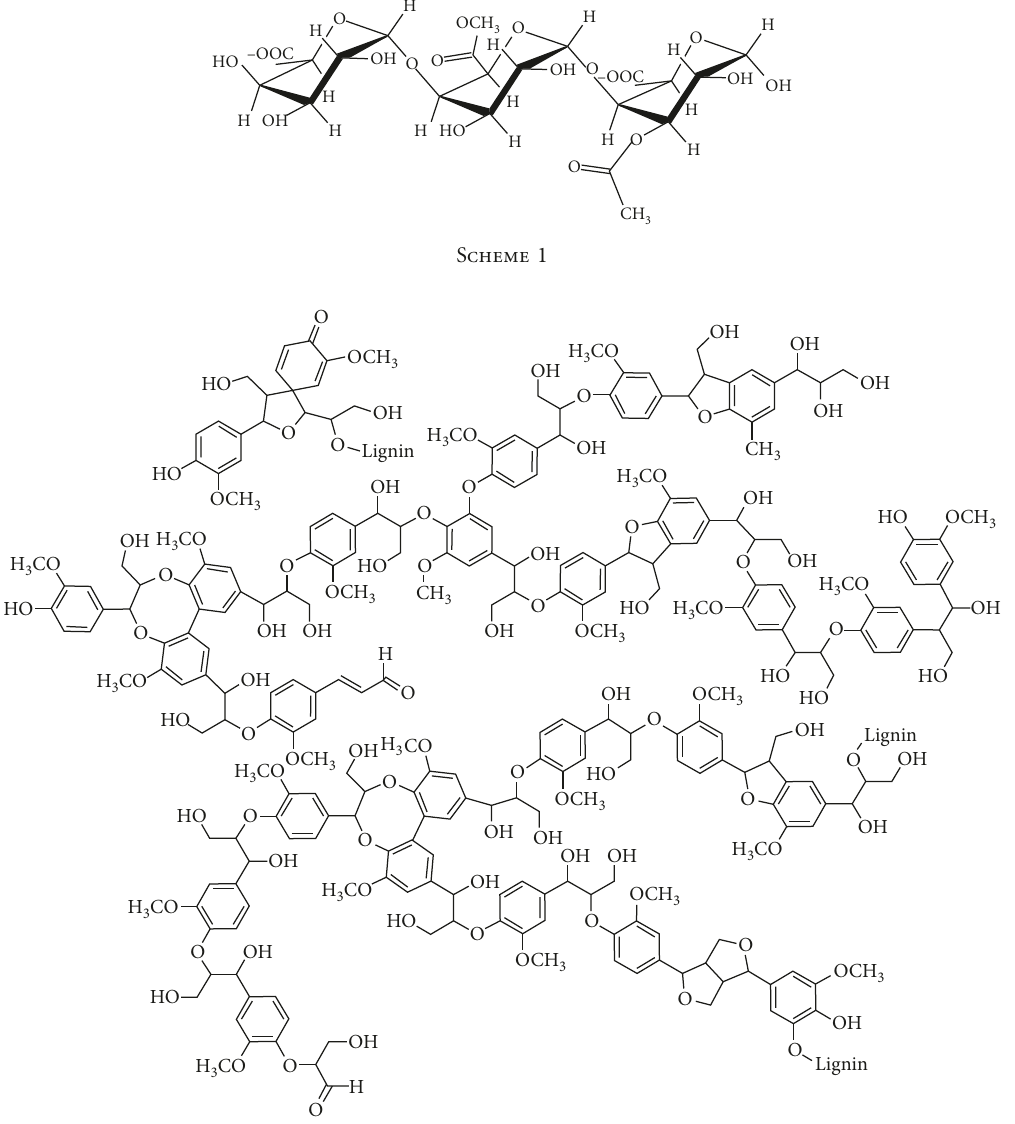
Figure 2: A fragment of the lignin structure according to